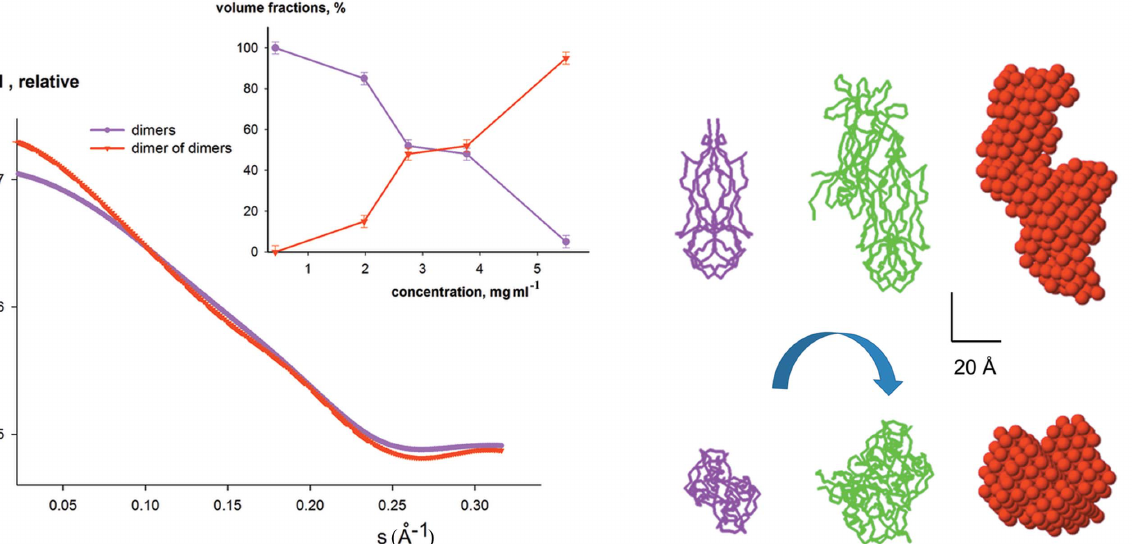
Figure 4 Analysis of NGF concentration-dependent oligomeric equilibrium [initial state; dimer model (PDB entry 1btg); intermediate state, unknown oligomer; final state, set to ‘none’]. The top left panel displays the experimental data (dots with error bars), and the DAMMIX fits as red solid lines. The previously reported models (dimer and head-to-head dimer of dimers) are shown in the bottom right panel with magenta and green C (cid:3) traces (Covaceuszach et al. , 2015). A typical restored shape of the unknown component obtained by DAMMIX is displayed in the bottom right panel with red beads. The scale bar is 20 A˚ . The scattering curves from the components are shown in the bottom left panel (the two most different restored curves for the intermediate obtained from multiple DAMMIX runs are shown with dashed red lines) and their restored volume fractions are displayed in the inset; the colours are the same as the bottom right panel and the error bars of volume fractions display the average dispersion over multiple DAMMIX